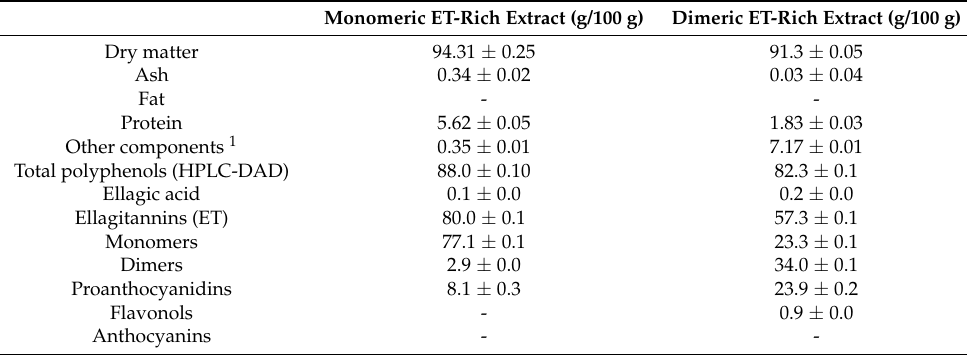
Table 1. Chemical composition of the strawberry ET